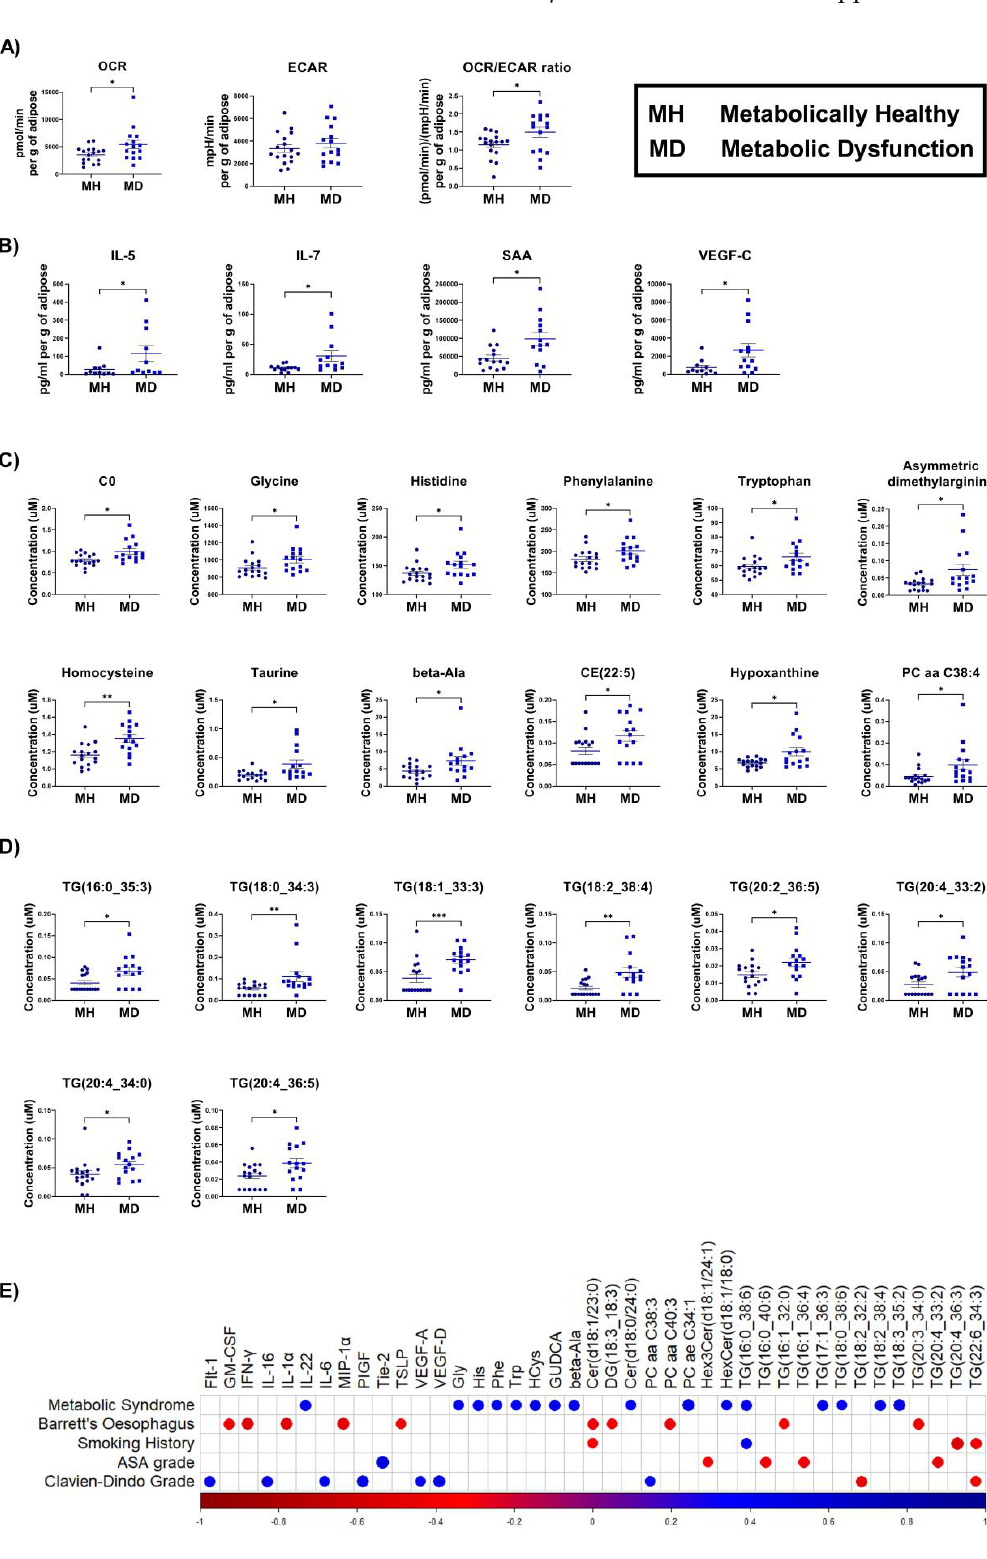
Figure 2. Altered OCR, OCR:ECAR ratio, pro-inflammatory cytokines, and metabolites in adipose explants from OAC patients with metabolic dysfunction compared with metabolically healthy